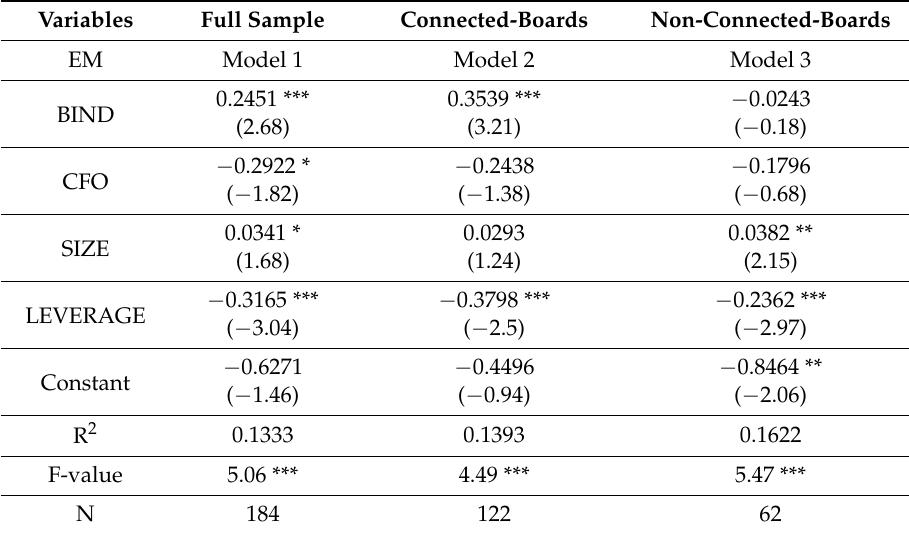
Table 4. Effects of board independence on earnings management in presence social relationships on earnings